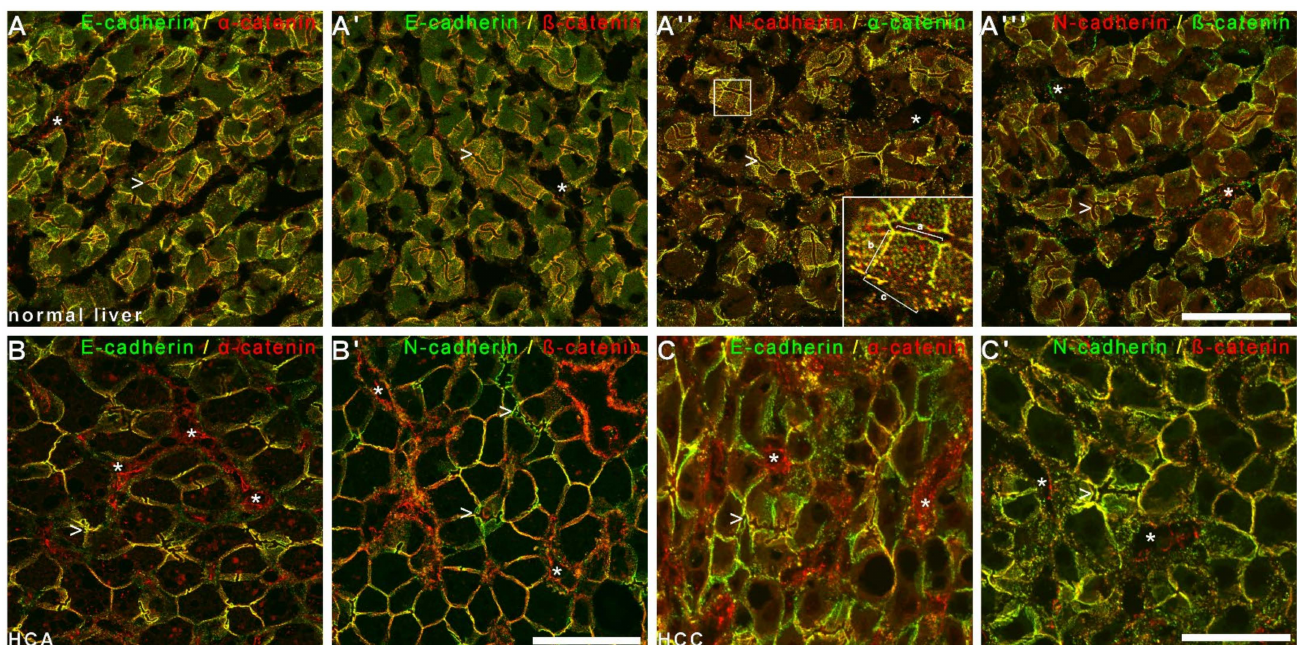
Figure 3. Colocalization of E- and N-cadherin with α - and β -catenin in normal liver, HCA, and HCC. Confocal laser scanning immunofluorescence microscopy of normal bovine liver ( A – A (cid:48)(cid:48)(cid:48) ), as well as human HCA ( B , B (cid:48) ) and human HCC ( C , C (cid:48) ) with antibodies against E-cadherin (mouse, Alexa 488, green), and N-cadherin ( A (cid:48)(cid:48) , A (cid:48)(cid:48)(cid:48) : rb, cy3, red, B (cid:48) and C (cid:48) : mouse Alexa 488, green) together with antibodies against α - and β -catenin ( A , A (cid:48) , B , B (cid:48) , C , C (cid:48) : rb cy3, red; and A (cid:48)(cid:48) , A (cid:48)(cid:48)(cid:48) : mouse Alexa 488, green) showed complete colocalization at the membranes of hepatocytes and hepatocellular tumor cells. Vascular spaces are lined with endothelial cells that stain with α - and β -catenin, but not E- and N-cadherin (stars). For a frontal plane of hepatocytes see insert in A (cid:48)(cid:48) with AJs of the canaliculi in direction of the apical membrane (a, see also arrowheads in all images), lateral membrane (b), and basal membrane (c). At the basal membrane, dot-like AJ complexes of N-cadherin together with α - and β -catenin, but not E-cadherin are noted, mutually corresponding to AJs of hepatic stellate cells ( A (cid:48)(cid:48) , c, compare A , A (cid:48) to A (cid:48)(cid:48) , A (cid:48)(cid:48)(cid:48) ). Bars: each 50 µ